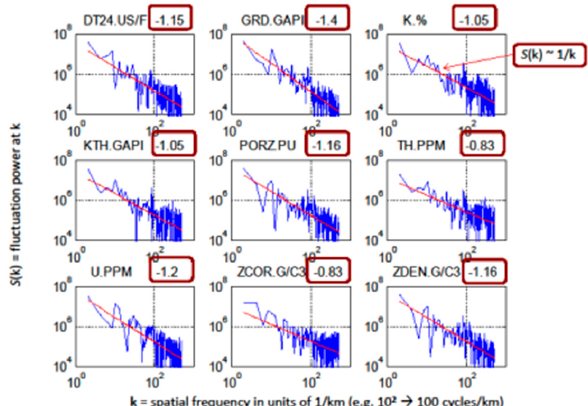
Figure 5. Time-series analysis well-log properties related to flow in fractures. From top left to bottom right, these properties are: acoustic velocity, gamma ray intensity, potassium abundance, potassium-thorium abundance, neutron porosity, thorium abundance, uranium abundance, mass density correlation, and mass density. In all these panels, the spectral density S(k) (y-axis) falls off with frequency as ~1/k, where k is spatial scale-length measured in number of cycles per km (x-axis). Data are from a sand-shale well-log provided to us courtesy of R Slatt [21,22]. The power-scaling exponent is shown in the red box at the upper right of each plot.